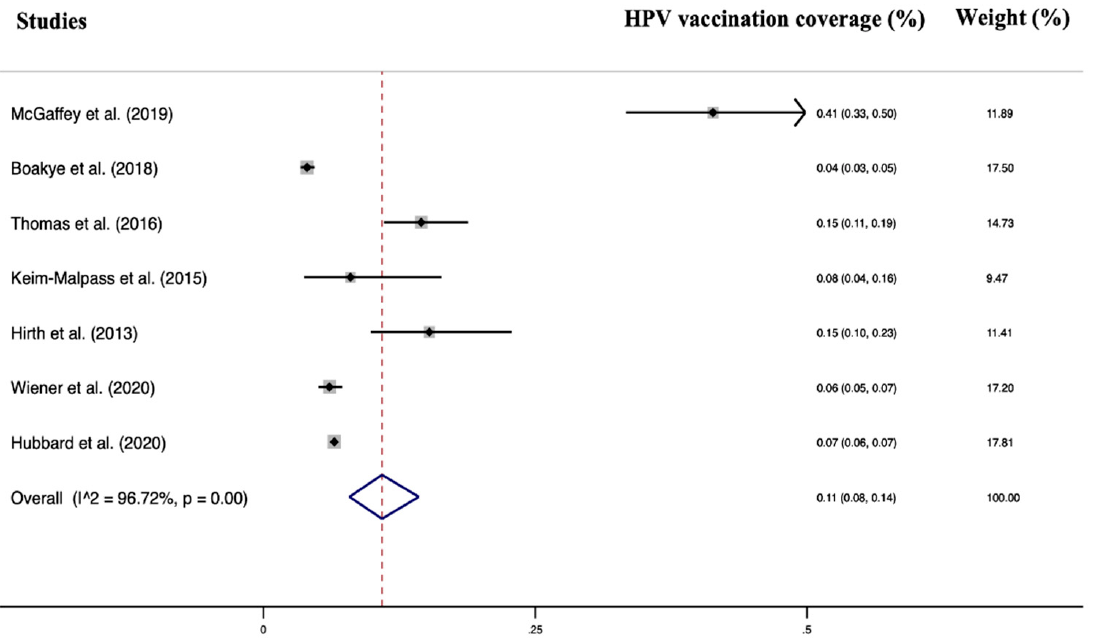
Figure 2. Forest plot of the included studies [23–30].